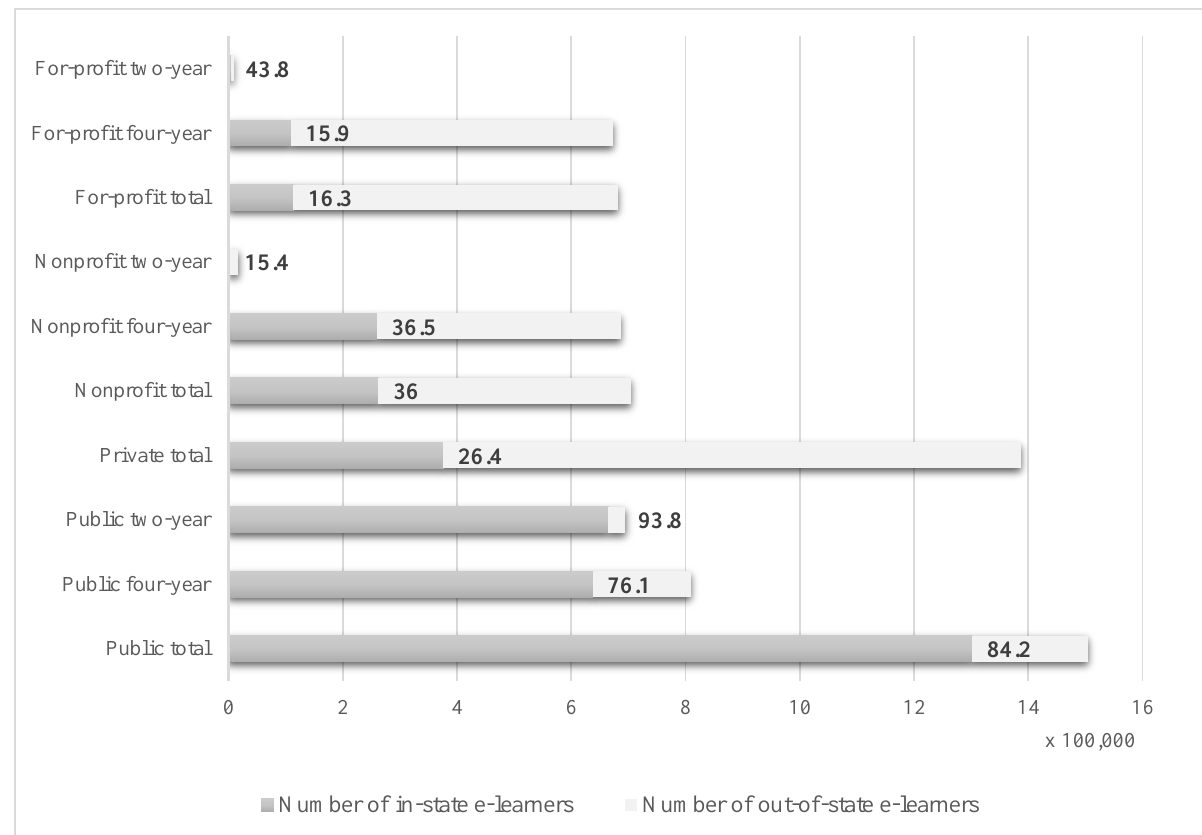
Figure 1 . Number and percentage of e-learners by institutional type and location of students in fall 2016. Adapted from “Table 311.15. Number and percentage of students enrolled in degree-granting postsecondary institutions, by distance education participation, location of student, level of enrollment, and control and level of institution: Fall 2015 and fall 2016,” by U.S. Department of Education, National Center for Education Statistics, 2018 (https://nces.ed.gov/programs/digest/d17/tables/dt17_311.15.asp). In the public